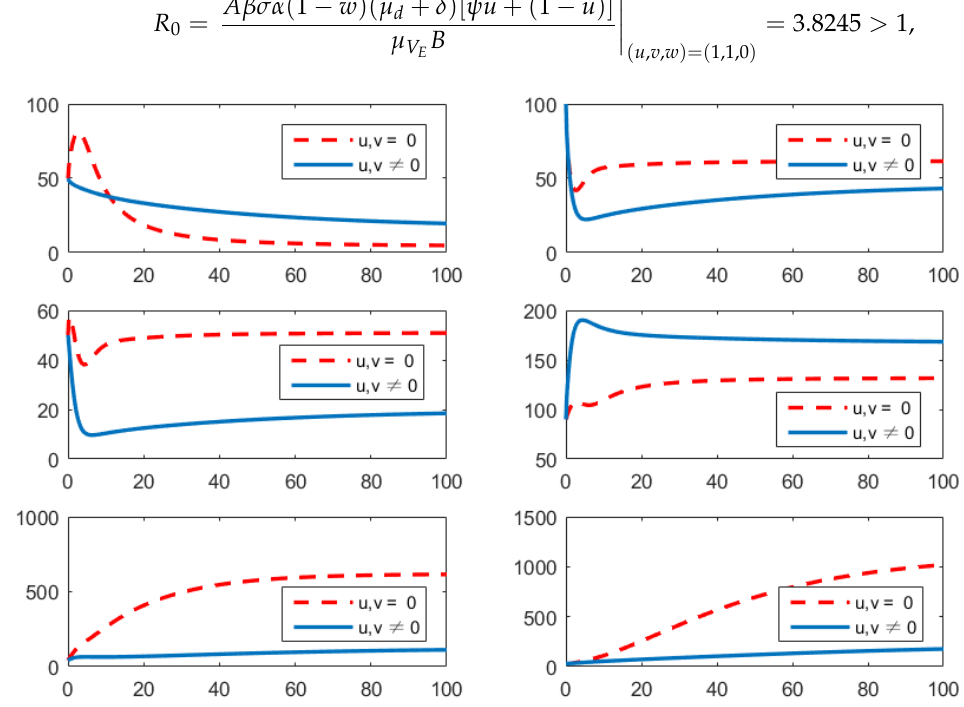
Figure 3. Comparison of adopting strategy A 2 versus not adopting. From left to right is S , E , I , R , V I , V E , respectively. The x -axis and y -axis, respectively, represent the time (days) and the corresponding population